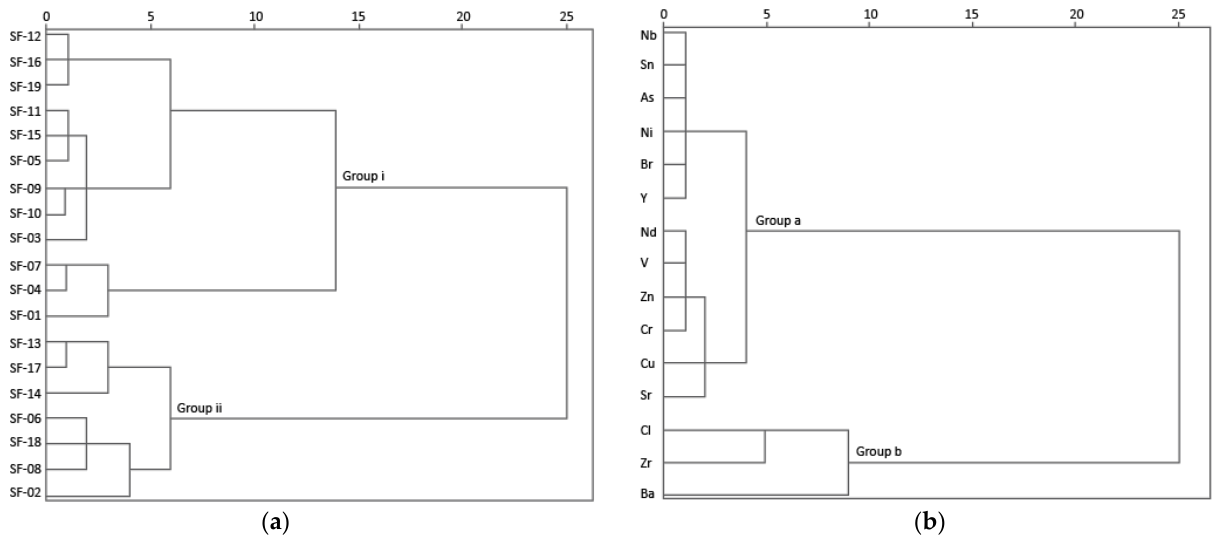
Figure 8. Cluster analysis of mortars and bricks samples trace element concentrations: ( a ) samples and ( b ) variables. The individual trace elements cluster analysis of CFM, MM and bricks samples was performed. The CFM samples revealed two groups, a cluster with SF05 sample (V–VII centuries) revealing affinity to SF01 (IV–V centuries), SF04 and SF07 (V–VII centuries), with higher Ba (500–820 mg/kg) and Cl (470–610 mg/kg) contents than the other cluster